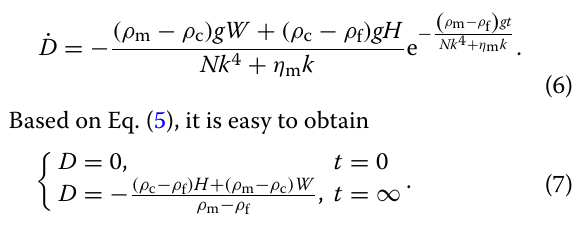
(Fig. 5a). The value of η m is about one order of